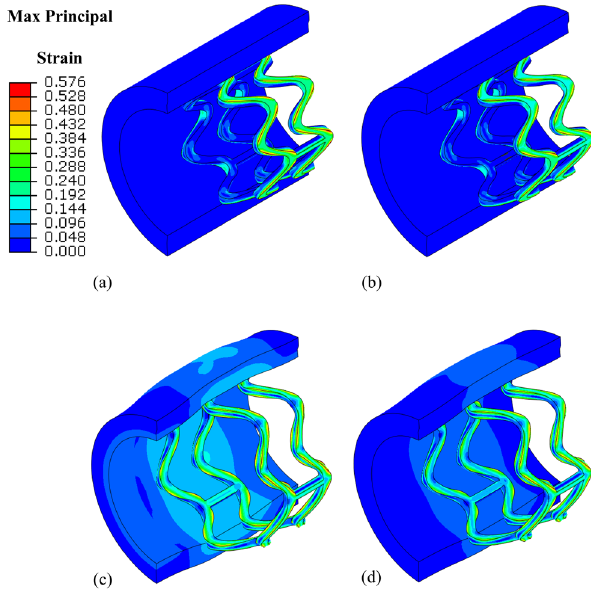
Figure 3: Stenting procedure before degradation. ( a ) The stent was crimped to an outer diameter of 2.5 mm. ( b ) The stent relaxed to an outer diameter of 2.65 mm at its crimped state. ( c ) The stent was fully expanded to an outer diameter of 3.5 mm. ( d ) The stent recoiled back with an outer diameter of 3.28 mm ( only half of the vessel was shown for clear illustration )